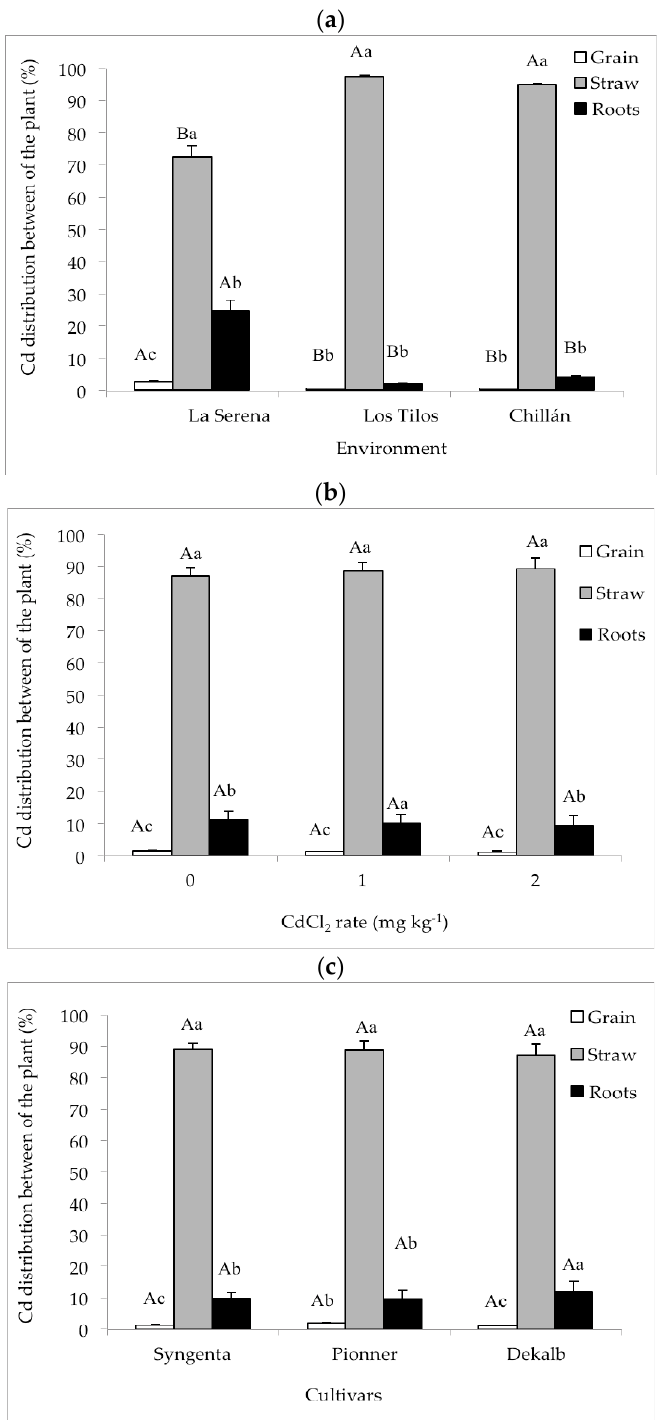
Figure 1. Cadmium distribution in the maize plant for different: ( a ) environments; ( b ) cadmium rates; and ( c ) maize cultivars.